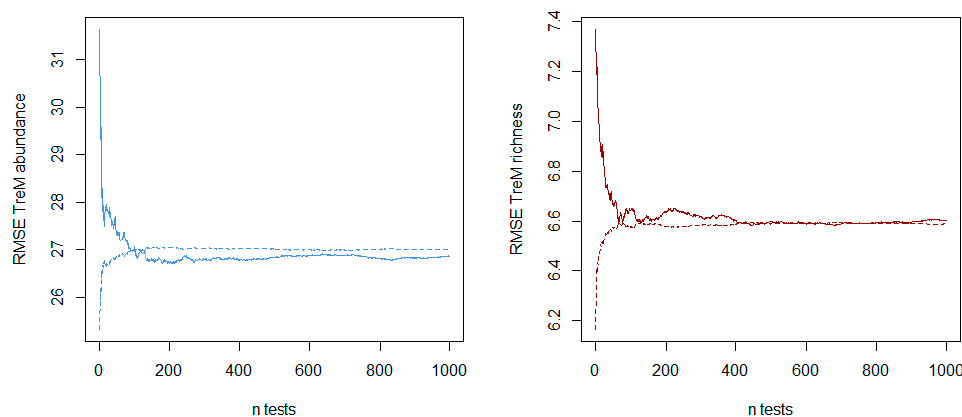
Figure 5. Results of the cross validation. Straight lines indicate the mean RMSE of the training data and dotted lines of the test data as cumulative mean up to the specific test (all RMSEs averaged until n -test). The left panel shows the results for TreM abundance, the right panel for TreM richness. The model that contained only data collected by UAV performed a little better for the TreM abundance prediction (+6% deviance explained), while the model that contained data collected by